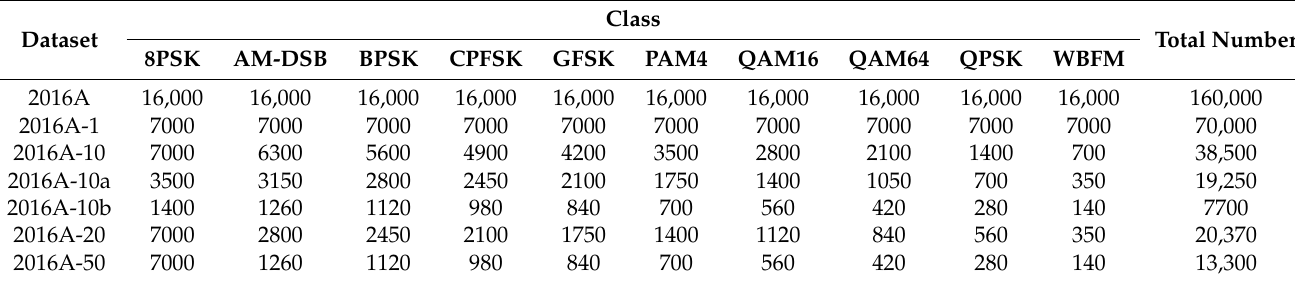
Table 2. The number of samples per class in the datasets used for the training